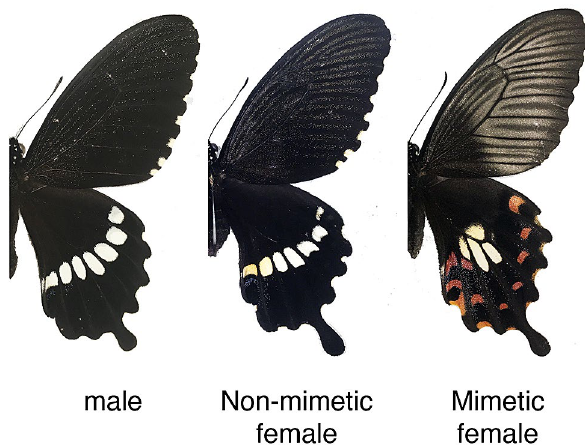
Figure 1. Wing patterns of adult male and non-mimetic and mimetic females of Papilio polytes . Photos by Shinya Komata. This figure was generated using Adobe Photoshop 2020 and Illustrator 2020 (Adobe Systems Incorporated, San Jose, CA,